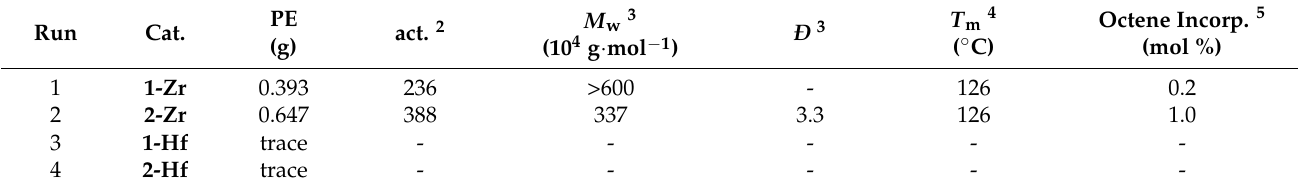
Table 1. Ethylene/1-Octene Copolymerization by Zr and Hf Complexes.